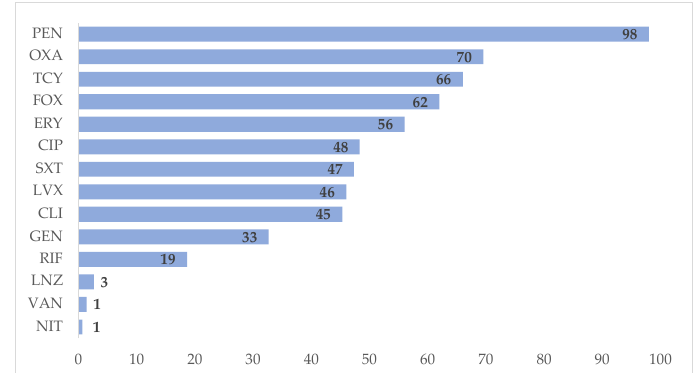
Figure 1. Antimicrobial resistance patterns in Staphylococcus aureus isolates at Yangon General Hospital, Myanmar, in 2018. X-axis represents the percentage of resistance. CIP = Ciprofloxacin, CLI = Clindamycin, ERY = Erythromycin, FOX = Cefoxitin, GEN = Gentamicin, LNZ = Linezolid, NIT = Nitrofurantoin, OXA = Oxacillin, PEN = Penicillin, RIF = Rifampin, SXT = Trimethoprim/Sulfamethoxazole, TCY = Tetracycline, VAN = Vancomycin.